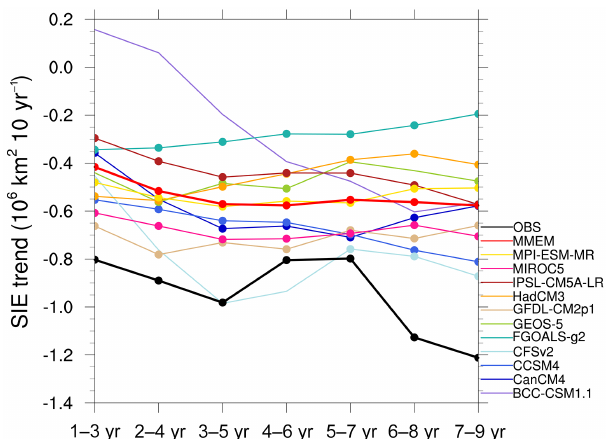
Figure 4. The predicted trends (slope of a linear regression) of September Arctic sea ice extent (SIE) anomalies as a function of the lead time after applying a 3-year average. The dots represent the trends exceeding 95% confidence